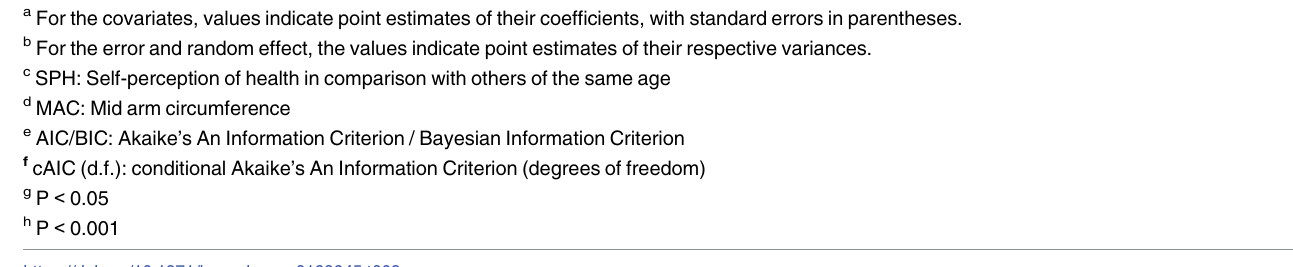
a For the covariates, values indicate point estimates of their coefficients, with standard errors in parentheses. b For the error and random effect, the values indicate point estimates of their respective variances.